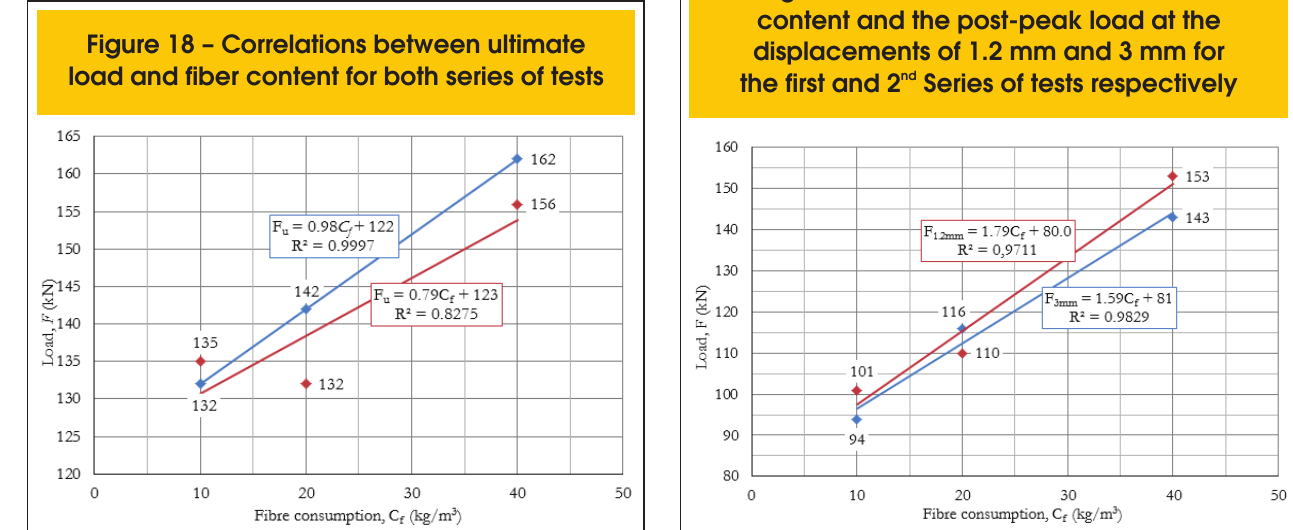
Figure 19 – Correlations between fiber content and the post-peak load at the displacements of 1.2 mm and 3 mm for nd the first and 2 Series of tests